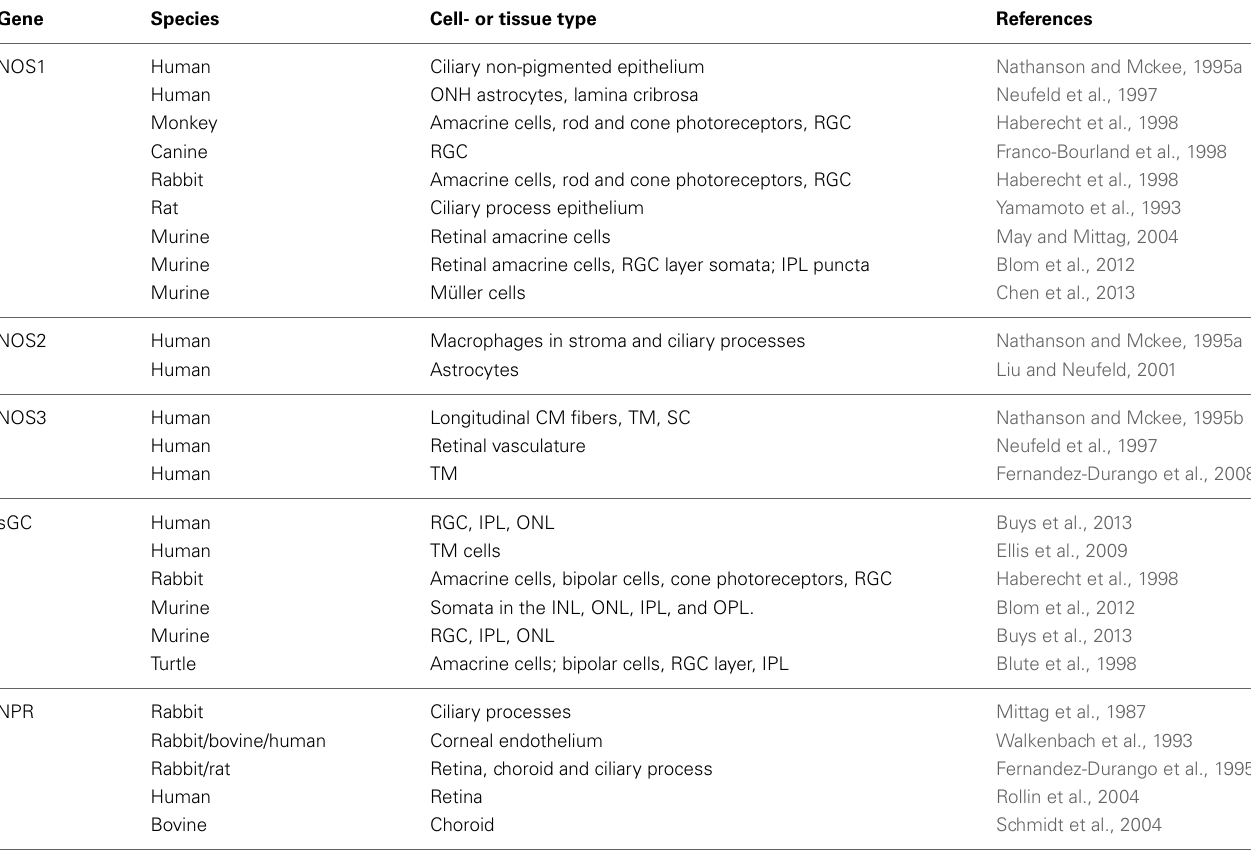
Table 1 | Ocular localization of nitric oxide synthase (NOS), soluble guanylate cyclase (sGC), and NP receptors (NPR).